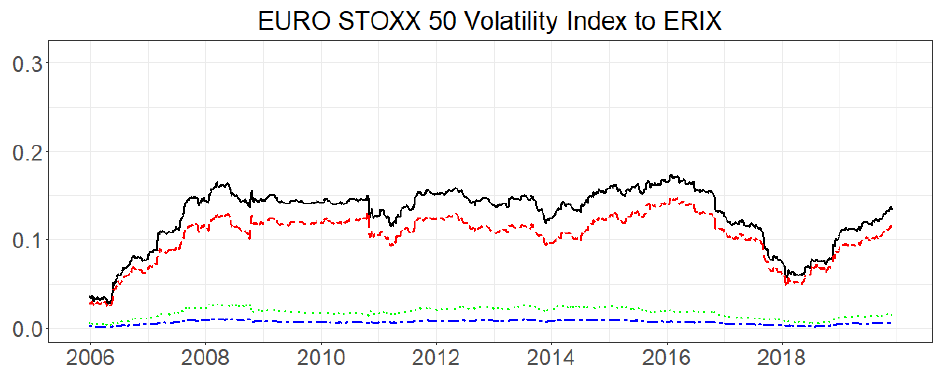
Figure 8. Diebold–Yilmaz [15] directional return spillover (pairwise) and Barunik–Krehlik [16] directional return spillover (pairwise) in Europe. Note: ERIX indicates European Renewable Energy